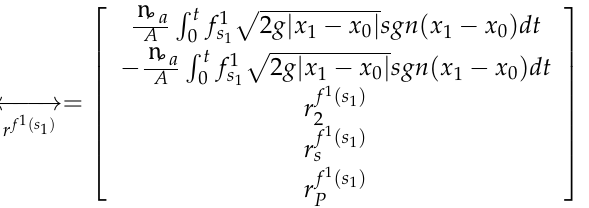
Figure 1. Three-pond hydraulic system.